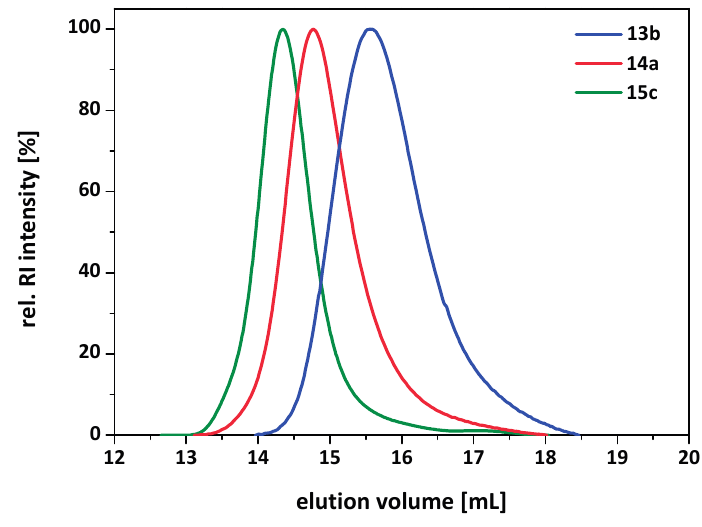
Figure 1. SEC traces of selected PNIPAAm star homo polymers.